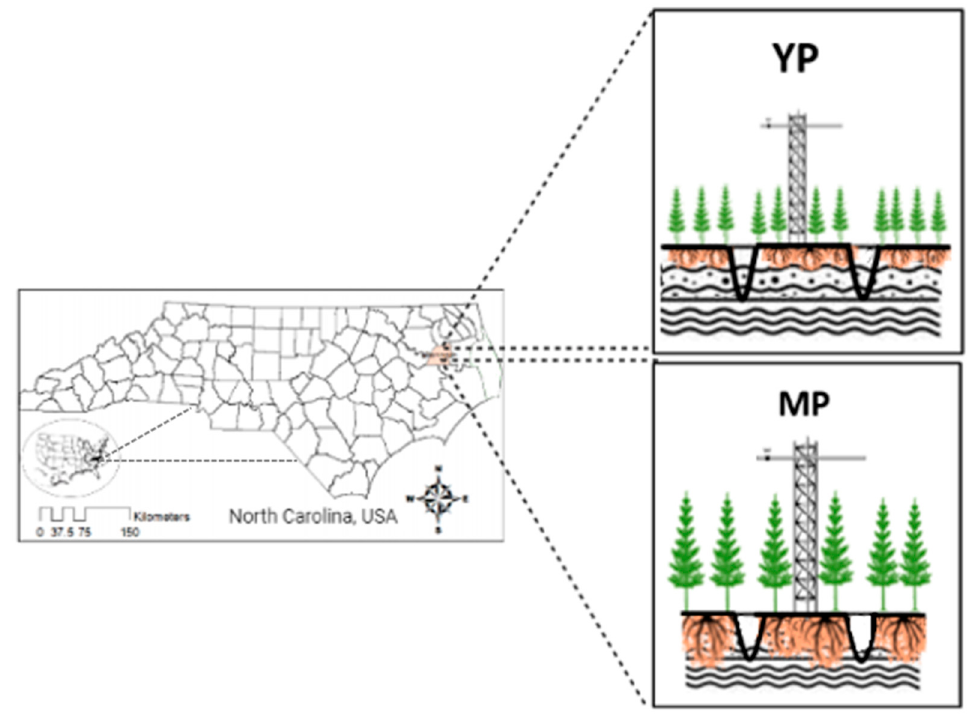
Figure 1. Map showing the location of YP and MP flux towers established in North Carolina,